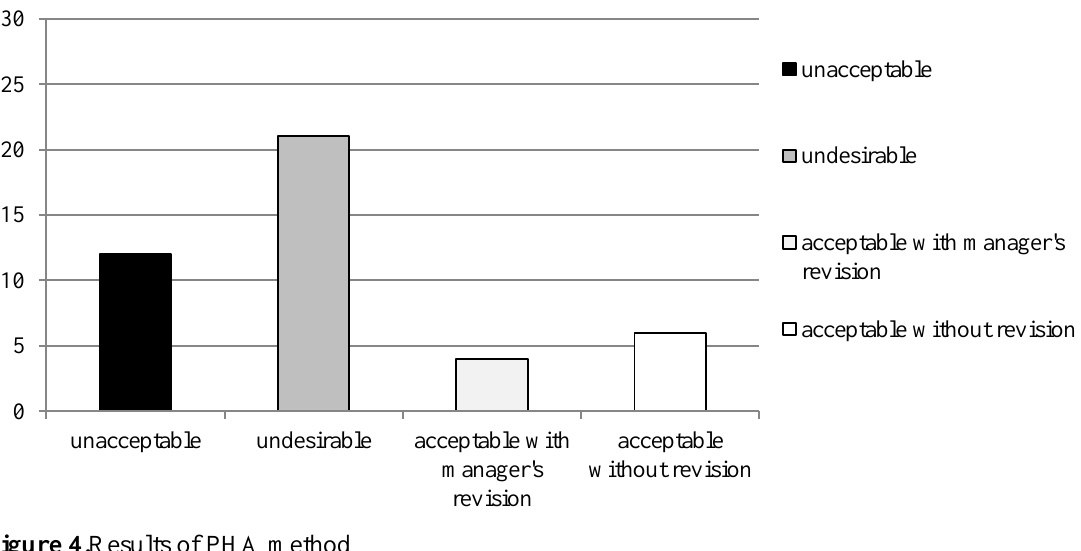
Figure 4. Results of PHA